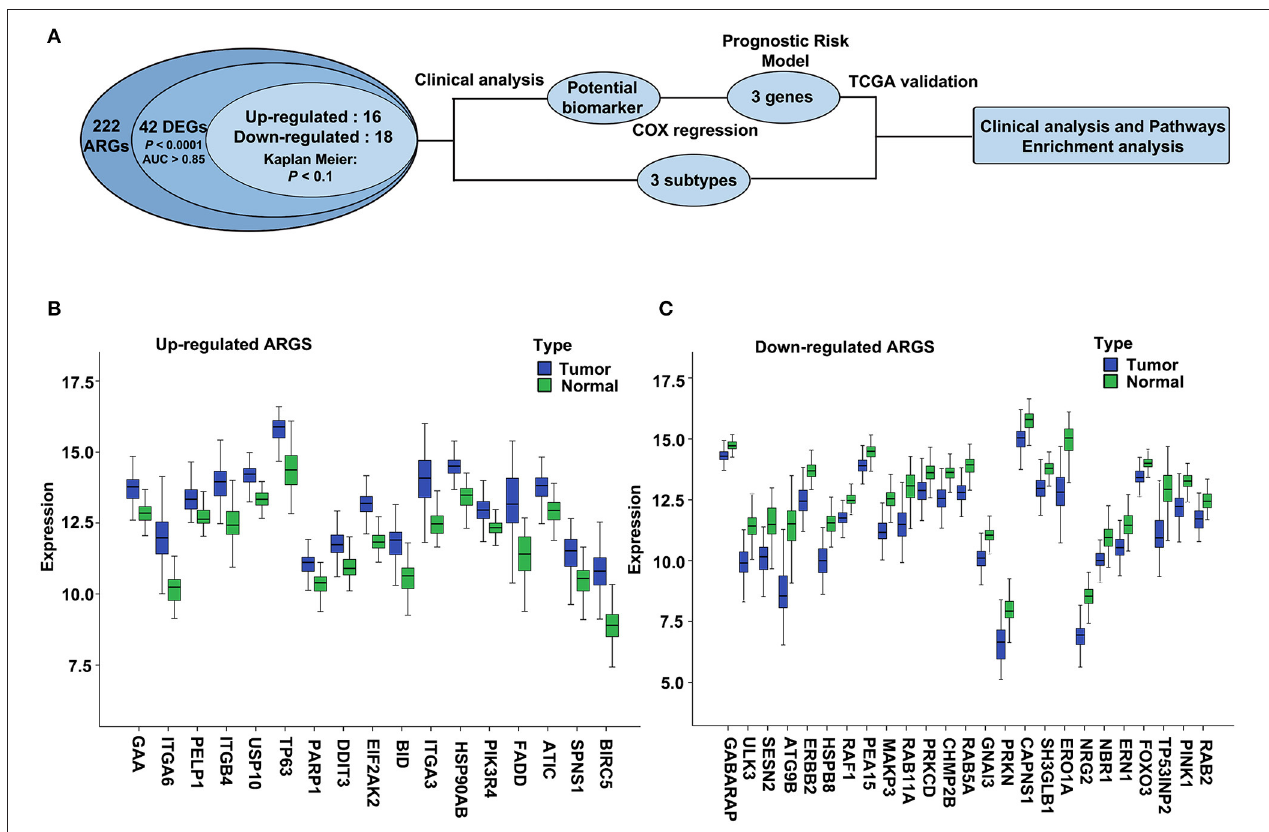
FIGURE 1 | The overall flowchart and significantly differentially expressed autophagy-related genes (ARGs) in esophageal squamous cell carcinoma (ESCC). (A) Procedure for the selection and validation of the prognostic risk model in ESCC. DEGs, differentially expressed genes. (B,C) The expression patterns of 42 ARGs in ESCC and paired normal samples. Blue box represents tumor, and green box represents normal. (B) Upregulated ARGs. (C) Downregulated ARGs. log2(FC) ≥ 0.5 or ≤ -0.5 ( Supplementary Table 3 ), and